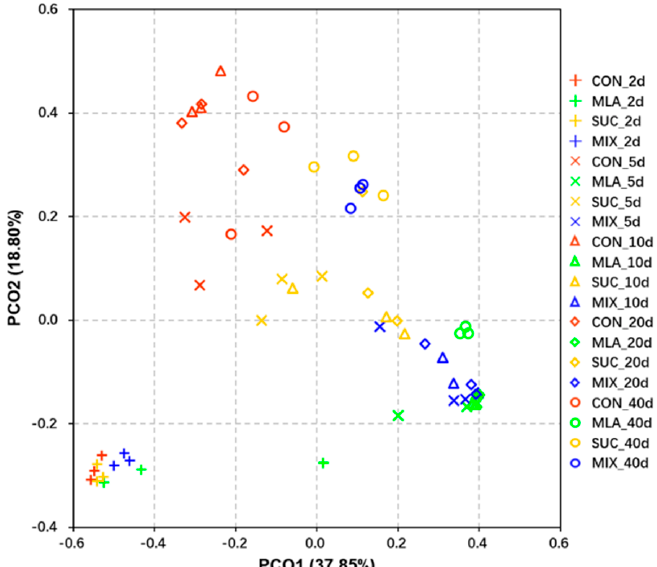
Figure 1. Principal co-ordinates analysis (PCoA) plot of bacterial communities in Moringa oleifera leaves silage. CON, control group; MLA, 1% malic acid addition on the fresh weight (FW) basis; SUC, 1% sucrose addition on the FW basis; MIX, 1% malic acid and 1% sucrose addition on the FW basis.